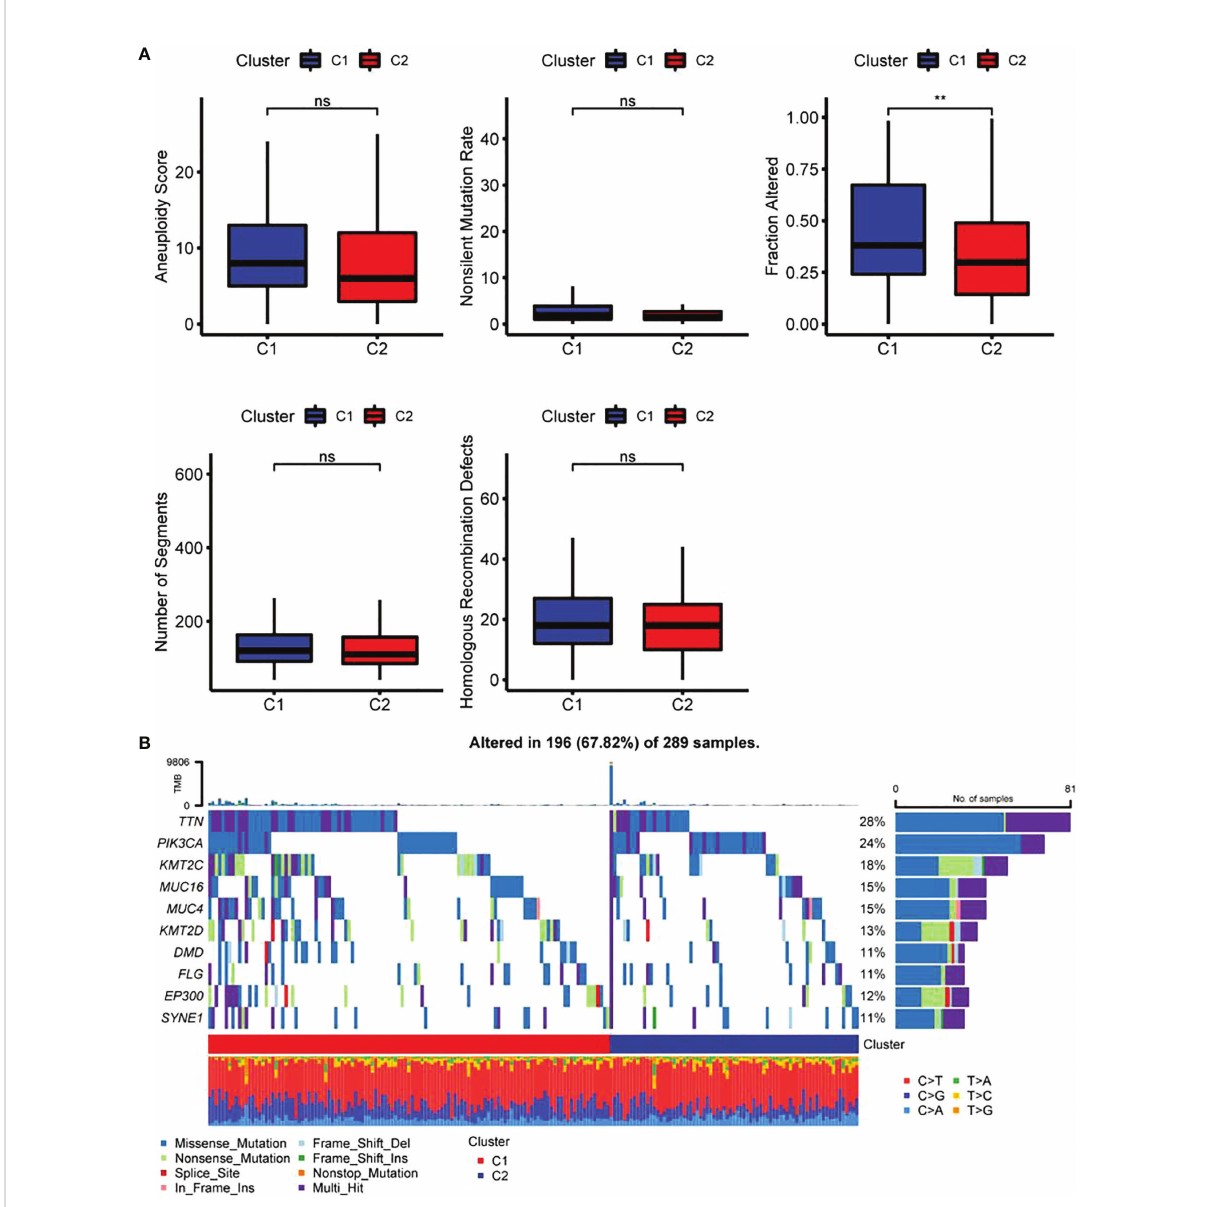
FIGURE 6 Differences in genome mutation between two fatty acid-related subtypes (A) Differences of Homologous Recombination Defects, Aneuploidy Score, Fraction Altered, Number of Segments and Tumor mutation burden in molecular subtypes in the TCGA cohort; (B) Somatic mutation landscape in two molecular subtypes. ** p<0.01, ns,